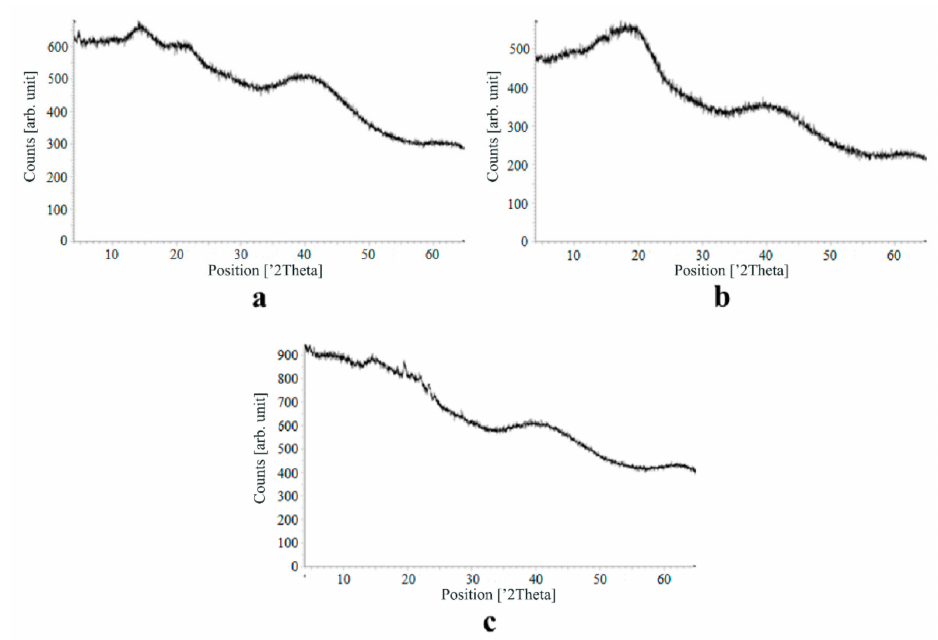
Figure 9. X-ray di ff raction patterns of nimesulide loaded into the alginate-based aerogel: ( a ) 5.50, ( b ) 5.56, ( c ) 14.96 wt%.